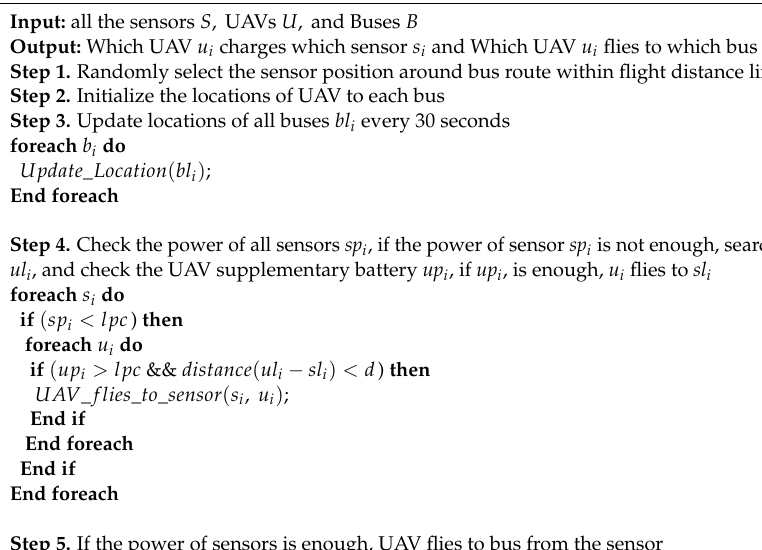
Algorithm 1: Charging Strategy with Naïve Charging